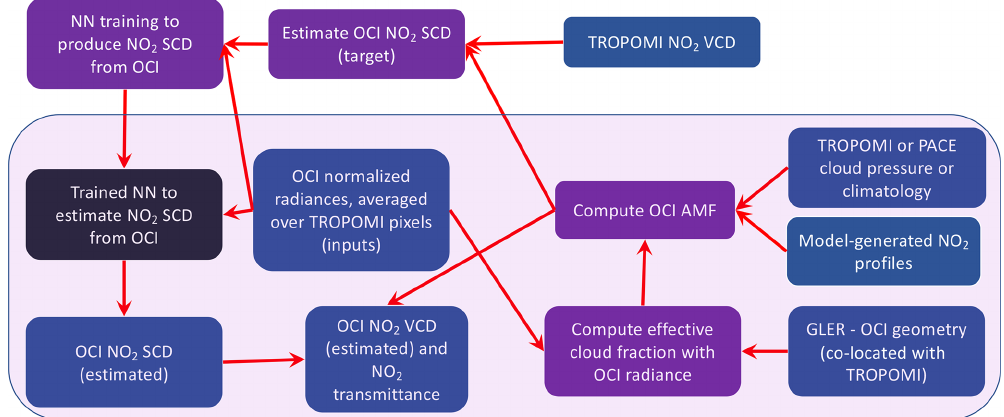
Figure 7. Flow diagram showing the processes and data needed to estimate the NO 2 VCD using TROPOMI data co-located with OCI. Data sets are indicated by blue boxes, dynamic processes are shown using purple, and a static process is displayed in black. Components needed to compute the VCD once the NN training process is complete are shown within the light purple overlay.